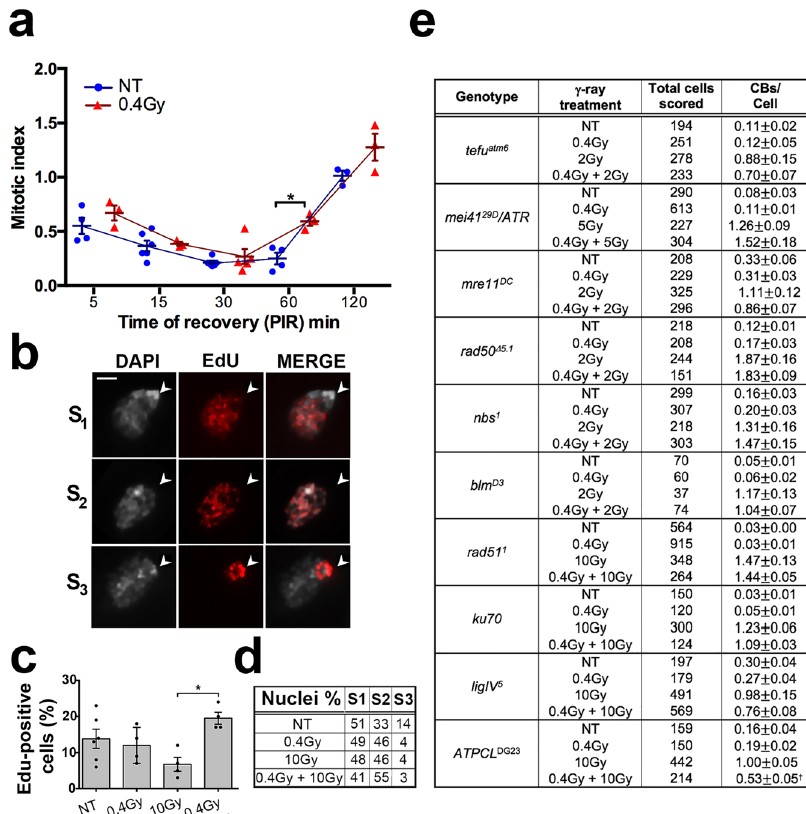
Fig. 2 The in fl uence of cell cycle and DNA Damage Response (DDR) on the RAR. a Checkpoint assay of Oregon -R 0.4 Gy LDR chronically exposed Oregon -R larval brains versus non-treated (NT) controls. In the picture is shown the mitotic index (MI) calculated as the ratio between the total number of dividing cells and the number of optical fi elds. Note that the MI of 0.4 Gy LDR larvae increases after 60 min post-irradiation compared to NT control. n = 3 biologically independent experiments were conducted. Values of p < 0.05 (*) were considered as statistically signi fi cant (Student t -test). b EdU incorporation analysis of Oregon -R larval brain cells exposed to IR. EdU-positive cell nuclei of larval brains show 3 different incorporation patterns: S 1 represents early S phase nuclei that do not incorporate Edu in the DAPI-stained chromocenter; S 2 represents mid-S phase nuclei that incorporate EdU in all DAPI-stained nuclei; S 3 shows nuclei in the late S-phase that incorporate EdU only in the chromocenter. c Frequencies of EdU positive nuclei. The frequencies of EdU positive nuclei in each sample (NT, 0.4 Gy LDR, 10 Gy, 0.4 Gy LDR + 10 Gy) were obtained by examining at least 2000 nuclei from 3 brains. Values of p < 0.05 (*) were considered as statistically signi fi cant (Student t -test). d Quanti fi cation (%) of EdU positive cells divided in S1, S2, and S3 phases according to the staining pattern observed in (b). No statistical differences were observed in treated cells compared to controls. e DNA repair gene mutant larvae do not elicit RAR. Frequency of CBs induced by an acute 2 Gy, 5 Gy or 10 Gy irradiation on 0.4 Gy LDR Drosophila strains mutated in genes involved in the DNA damage response (DDR). The ATPCL mutant was used as a control. Note that in all DNA repair (but not in ATPCL DG23 ) mutants RAR is abolished. ISOs isochromosome deletions, CDs chromatid deletions, CBs chromosome breaks, NT non-treated, PIR post-irradiation time. The comparisons of the CBs frequency were performed among 0.4 Gy LDR treated- and untreated mutants before and after the exposure to the challenging dose using Student ’ s t -test; † statistically signi fi cant for p < 0.01. Bar = 10 μ